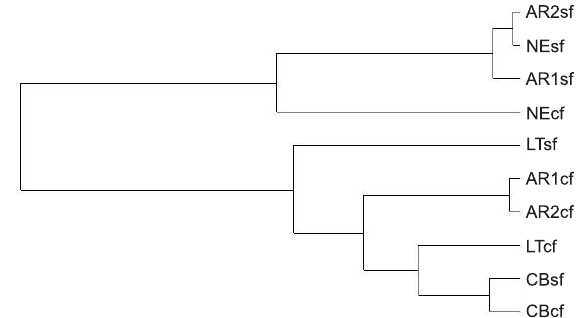
Figure 3. Ascending hierarchical classification of profiles in the 0–20 cm layer. (Soil: Cambissolo (CB) (Inceptisol), Latossolo (LT) (Oxisol), Neossolo (NE) (Entisol), Argissolo (AR1 and AR2) (Alfisol); cf: maize intercropped with jack bean, sf: sole